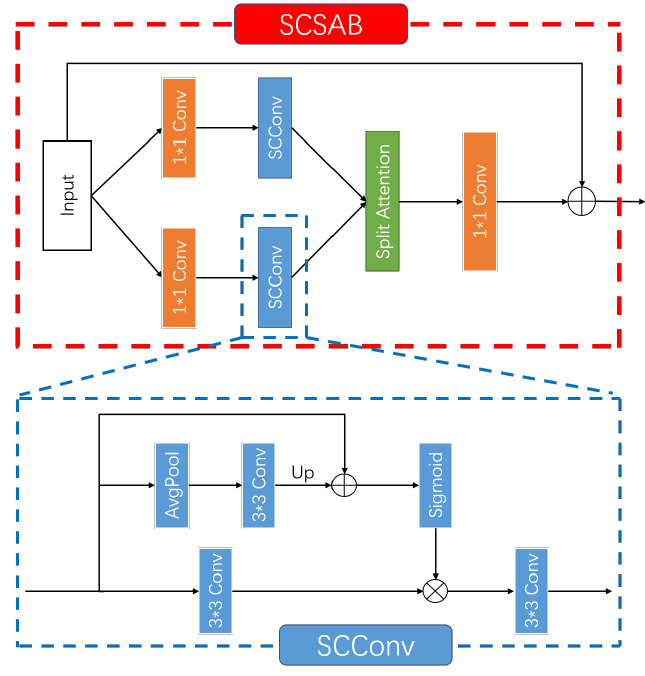
Figure 3. Architecture of SCSAB. AvgPool layer is used to produce a small scale space and Up is a bilinear interpolation operator that maps the small size feature space to the original size feature